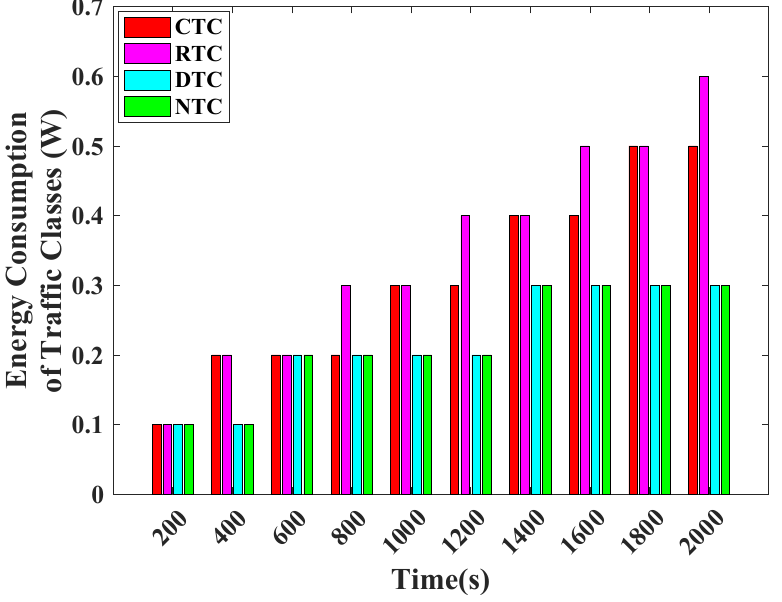
Figure 11. Energy consumption of traffic classes versus time in seconds